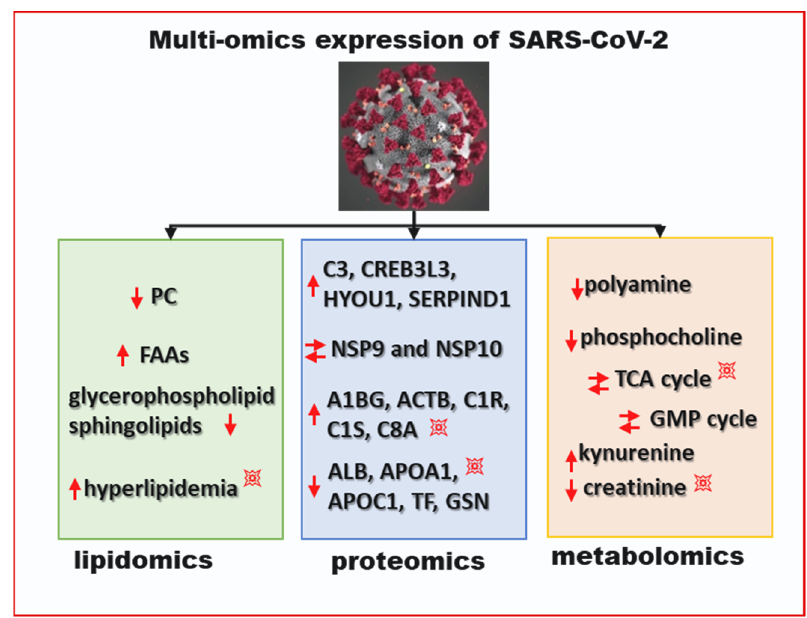
Figure 2. Multi-omics expression of SARS-CoV-2. The blast symbol ( 💥 ) designates the accentuated regulation of the process in T2DM. The down arrow indicates downregulation and the up arrow indicates upregulation; two parallel arrows symbolize differential expression compared to control after SARS-CoV-2 infection. PC: phosphatidylcholine; FAAs: free fatty acids; GMP: guanosine monophosphate; TCA: citric acid cycle.